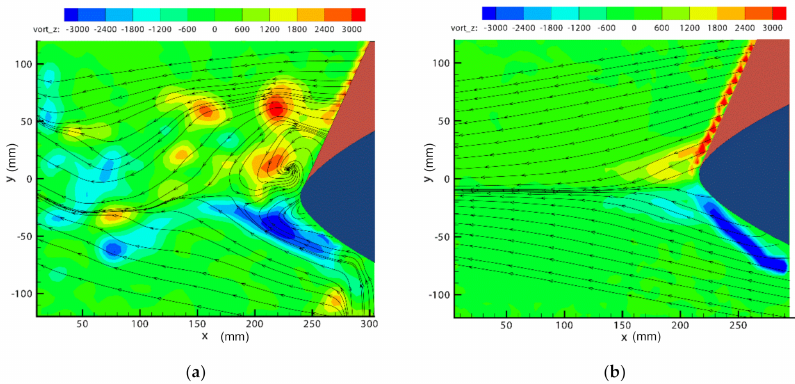
Figure 10. Velocity fields measured using PIV: ( a ) scale model without rings; ( b ) scale model with